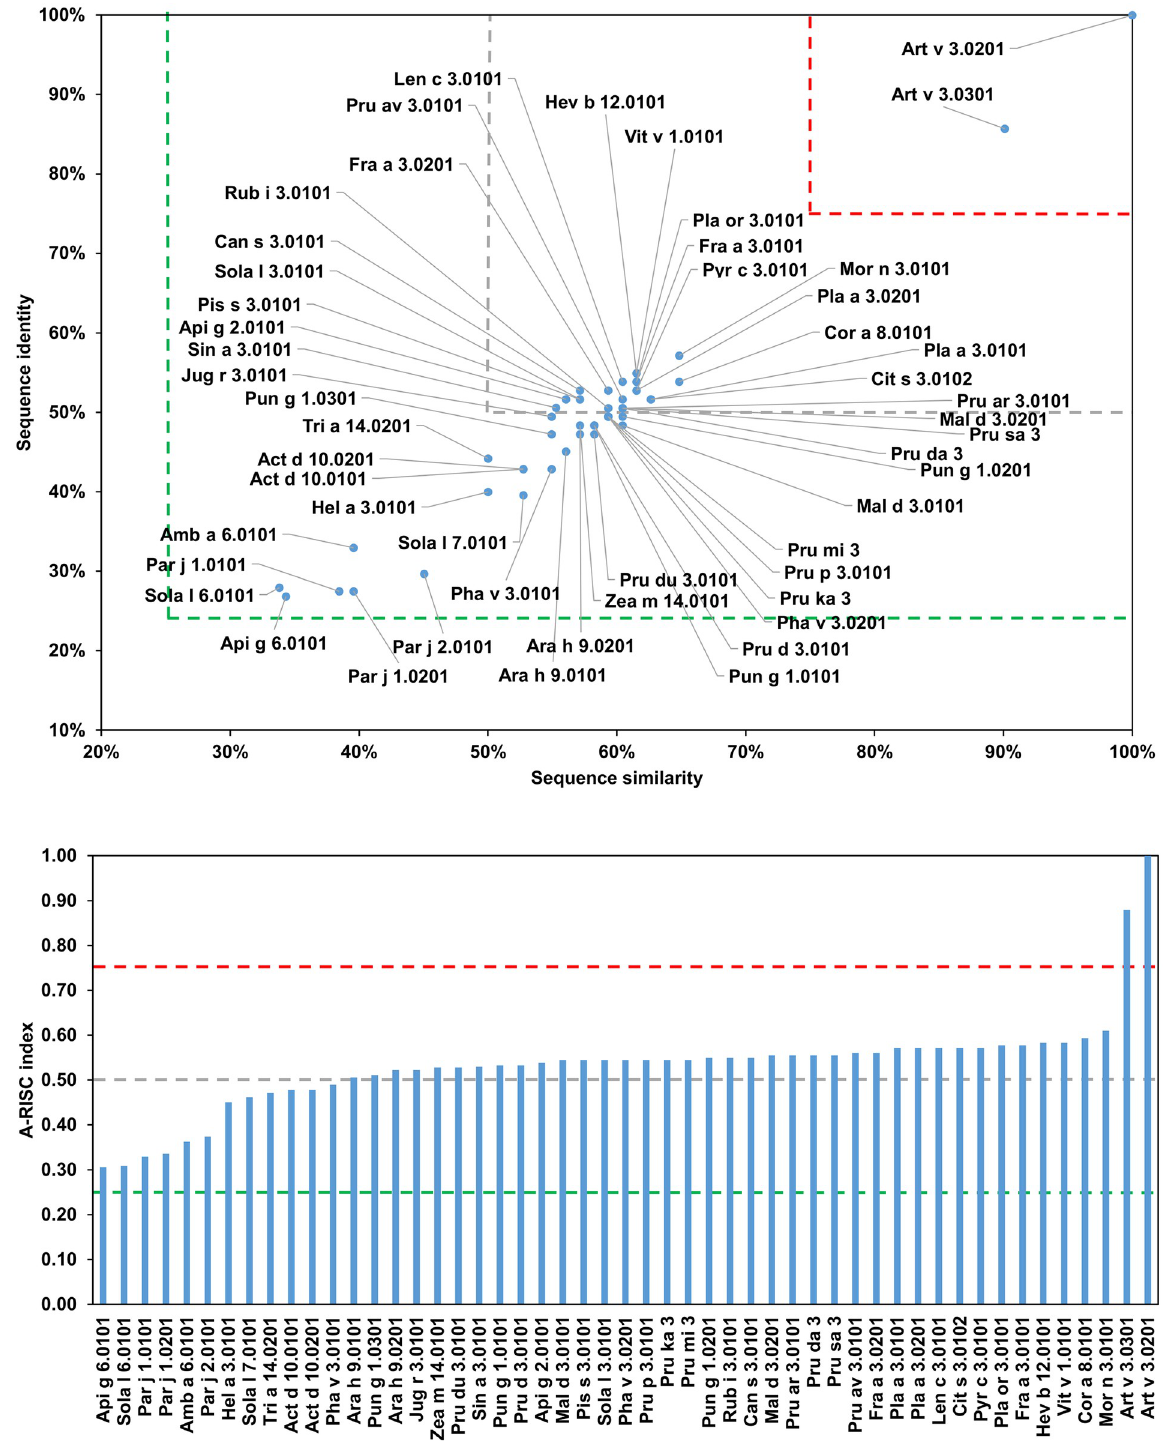
Fig 22. Plots showing relative homology and A-RISC indexes of allergens from nsLTP family. Comparison of the family members to Art v 3.0201. Red, gray and dark green dashed lines indicate respectively 75%, 50% and 25% sequence identity and similarity, or 0.75, 0.50 and 0.25 A-RISC